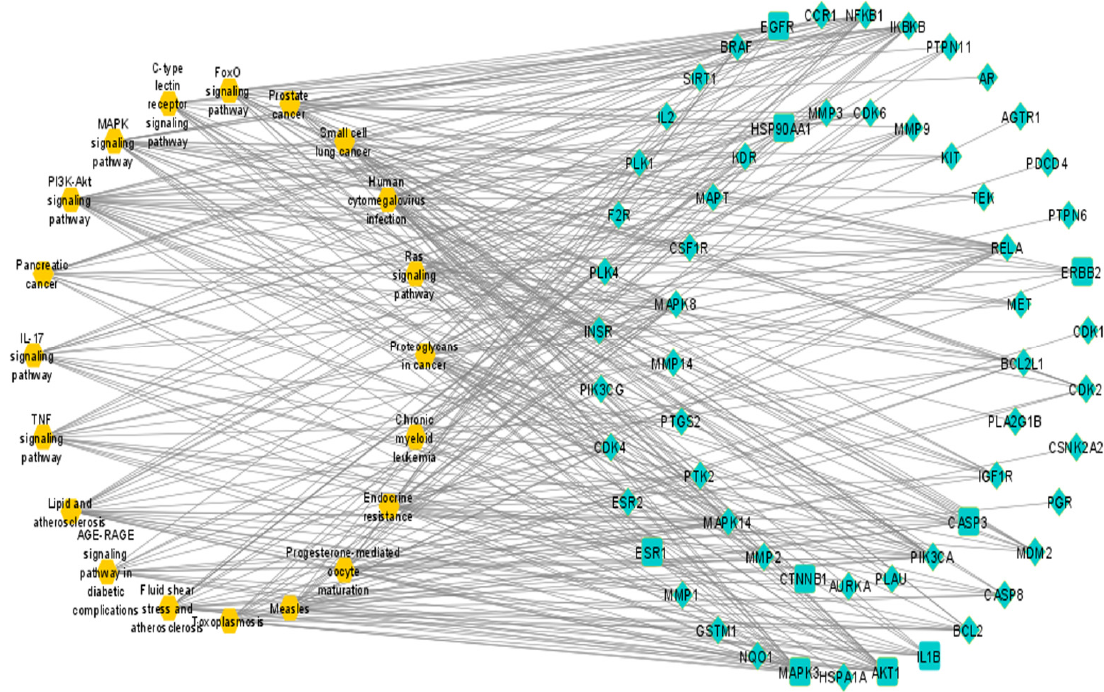
Figure 5. Hub genes enriched in top 20 signaling pathways. Signaling pathways are represented as hexagons and targets are represented as ellipses.